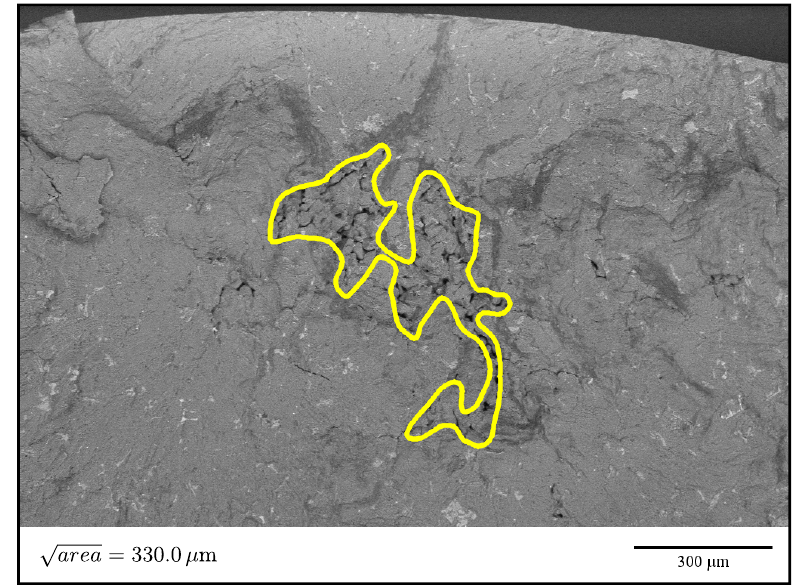
Figure 10. Fracture initiating defect at specimen